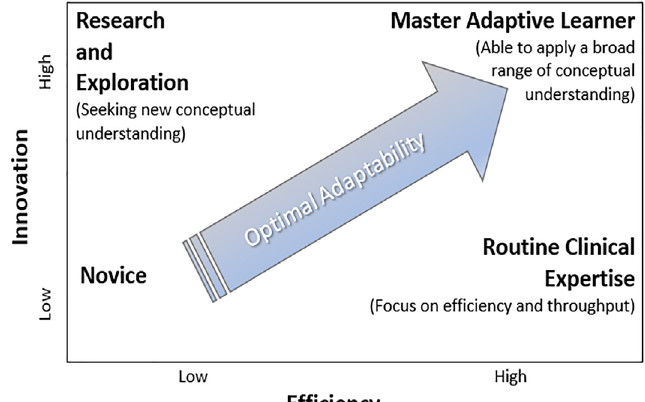
Figure. The balance of routine expertise (efficiency) and adaptive expertise (innovation) bound the optimal adaptability corridor (adapted from Bransford et al. 15